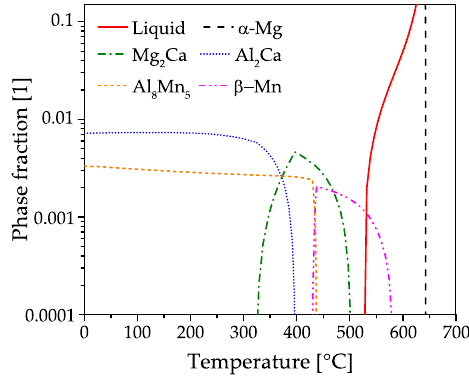
Fig. 1 Thermodynamic equilibrium calculations for the alloy AXMZ1000. Showing equilibrium phase fractions of 𝛼 -Mg and the liquid as well as the intermetallic phases Al 2 Ca, Mg 2 Ca, Al 𝛽 -Mn as a function of temperature